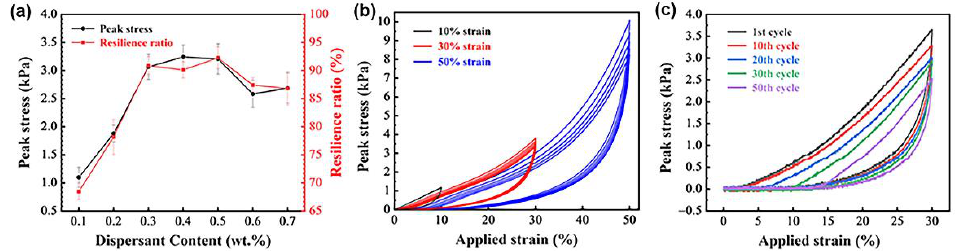
Figure 8. ( a ) Peak stress and resilience ratio of SiO 2 fibrous porous materials with different SHMP contents at 30% applied strain after 5 compression cycles. ( b ) Compressive rebound curves of SiO 2 fibrous porous materials under different applied strains for 5 cycles. ( c ) Compressive rebound curves of SiO 2 fibrous porous materials under 30% applied strain for different cycles.